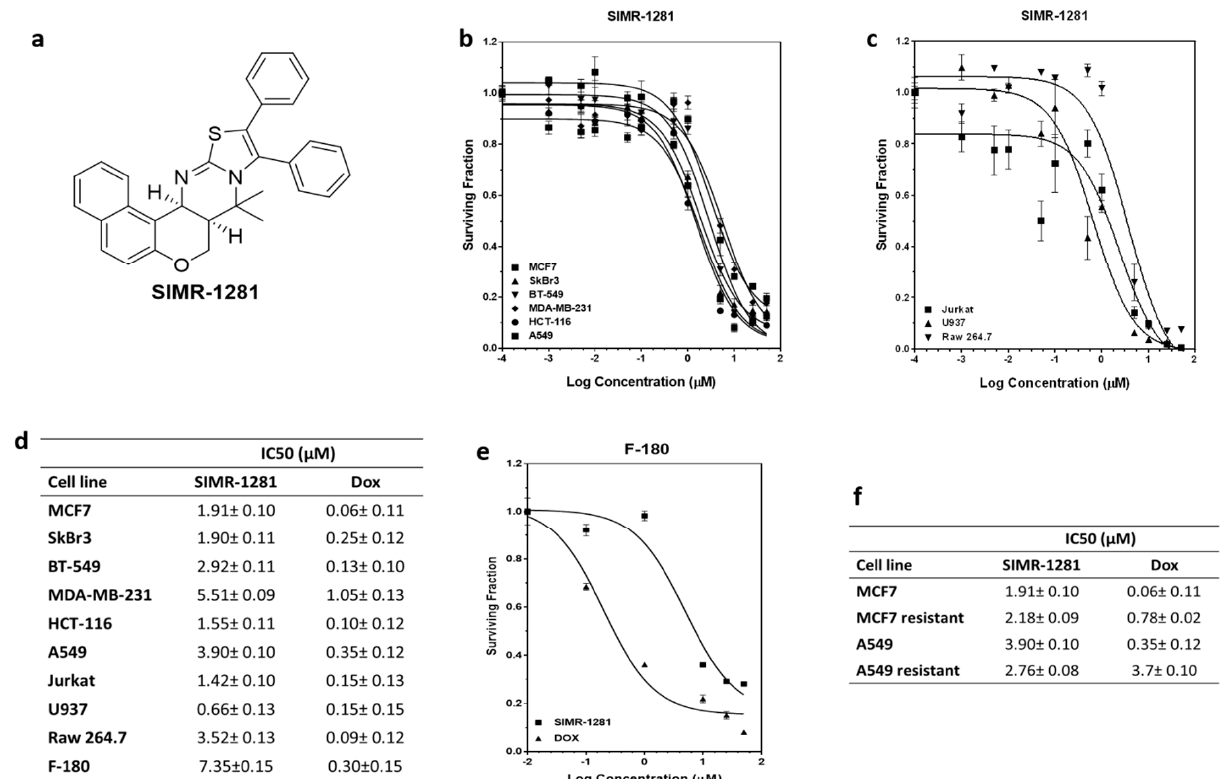
Figure 1. The antiproliferative effect of SIMR1281 on a panel of cancer cell lines and normal fibroblast cells (F-180). ( a ) Chemical structure of SIMR1281. ( b , c ) Dose-dependent effect of SIMR1281 on the indicated cell lines. ( d ) The IC 50 s of SIMR1281 in cancer cell lines and in normal F-180 cells, Data are mean ± SEM ( n = 3). ( e ) Surviving fraction of SIMR1281 and doxorubicin-treated F-180 cells. ( f ) The IC 50 of SIMR1281 in MCF7 and A549 cancer cell lines that acquired resistance to cancer medications, data are mean ± SEM ( n = 3).